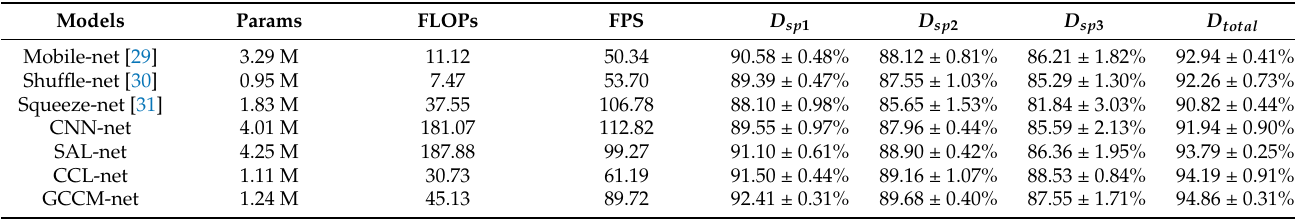
Table 2. Ablation study